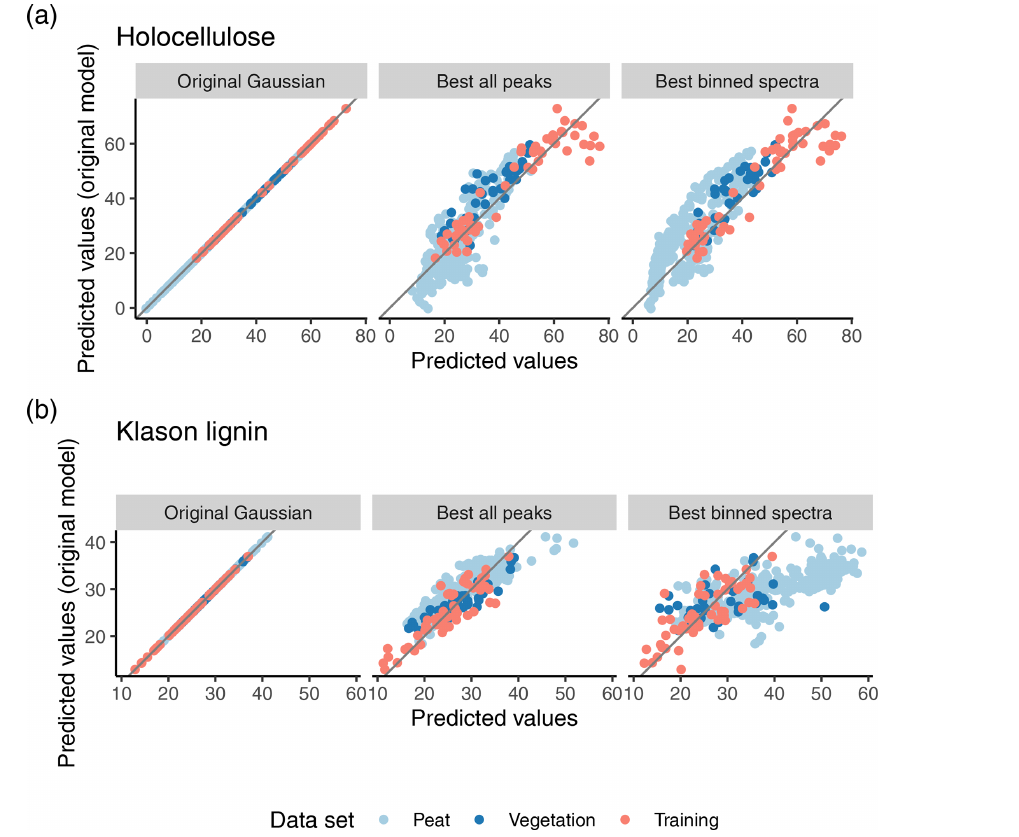
Figure 5. Predicted values of the original model versus predicted values of the original model (first column), and the best improved models using extracted peaks (second column) and binned spectra (last column), respectively, for holocellulose (a) and Klason lignin (b) , respec- tively. Colors differentiate the training, peat, and vegetation data from Hodgkins et al.